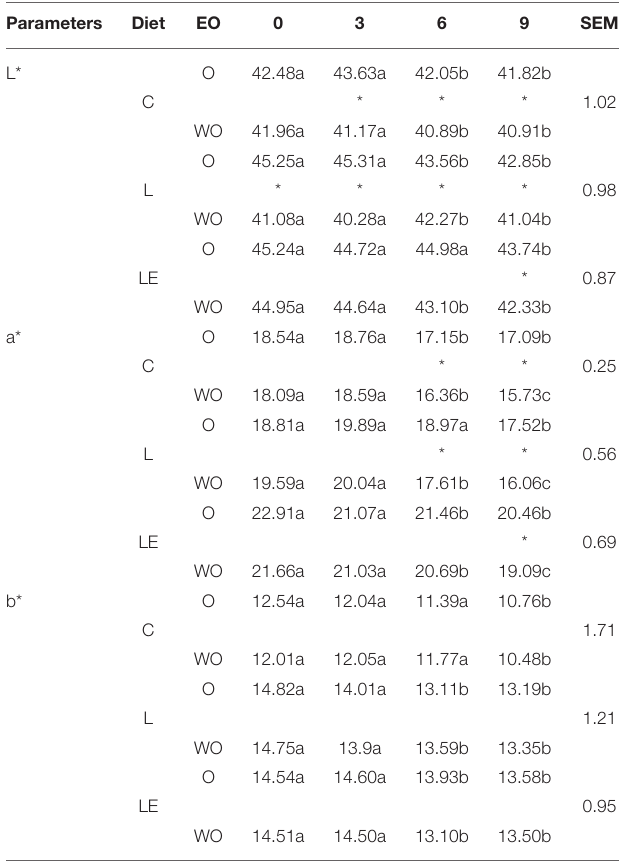
TABLE 4 | Effects of time (0, 3, 6, and 9 days of storage), diets (C, L, and LE), and essential oils (O and WO) on Marchigiana beef meat color parameters (L * , a * , and b *